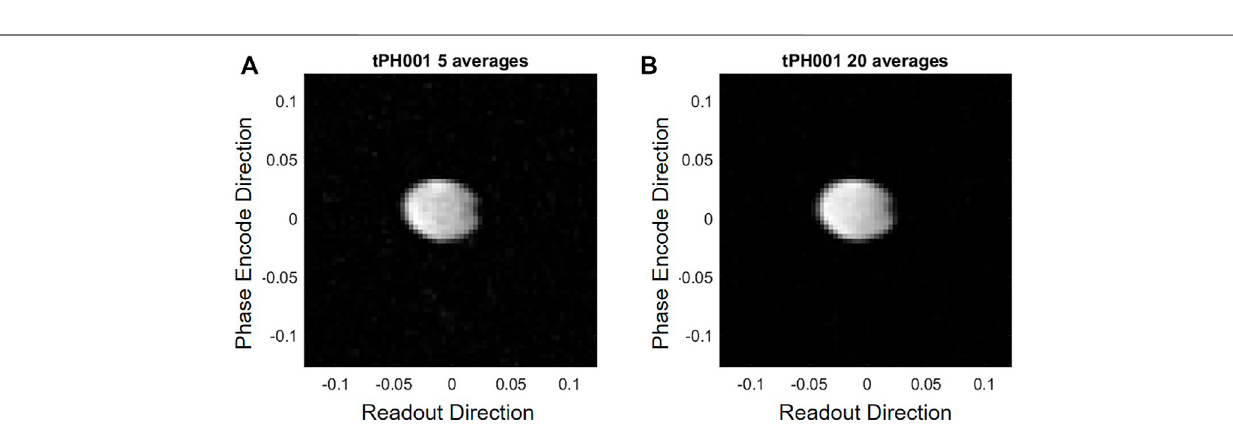
Frontiers in Physics |